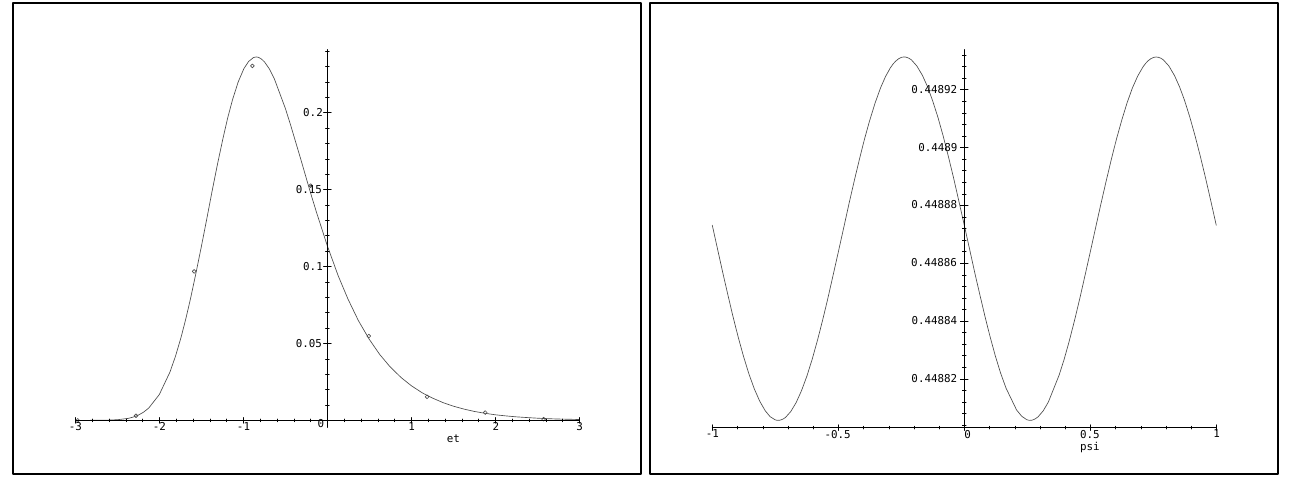
Fig. 10: P (cid:1) 2 0 (cid:3) as a function of y (cid:2)